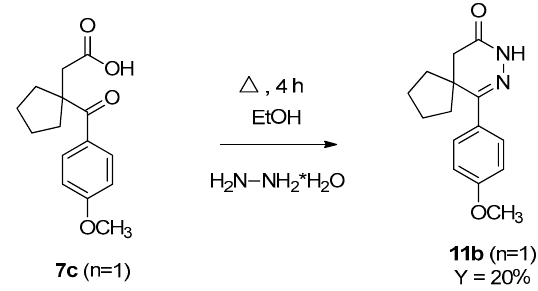
Scheme 5. Ring closure of the isomeric compound 7c . Table 2. Fsp 3 values of pyridazinones.